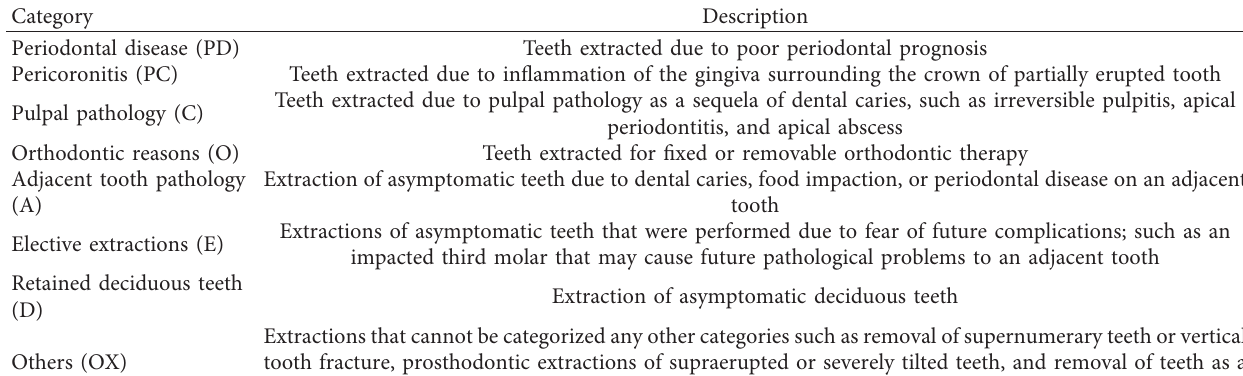
Table 1: Indications for tooth extraction.